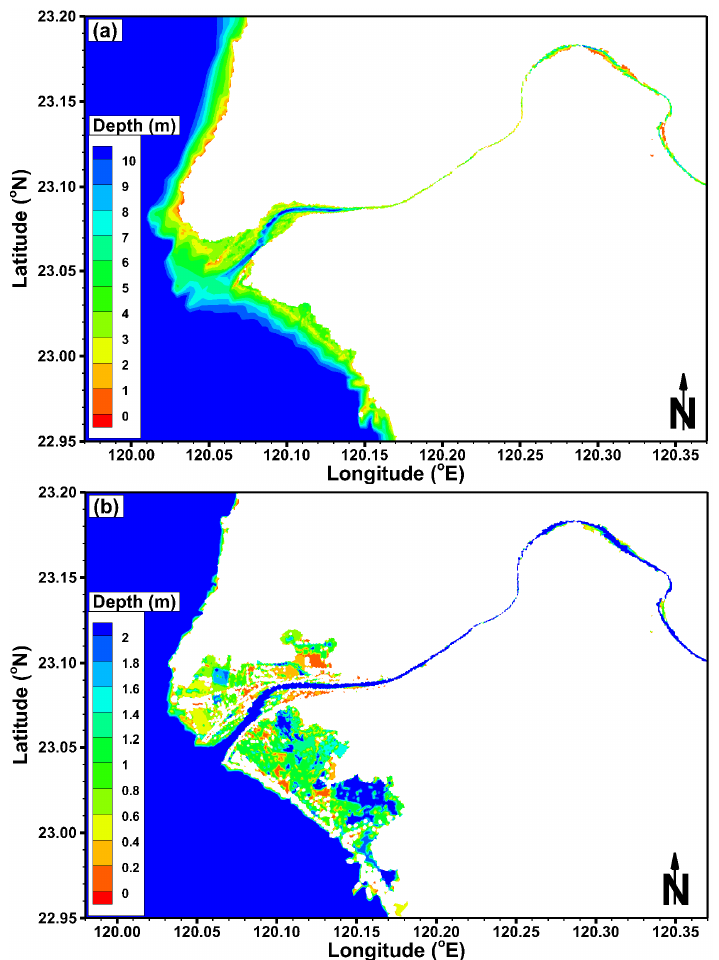
Figure 9. Inundation extent and depth induced by a storm surge at simulation times of ( a ) 99 h and ( b ) 168